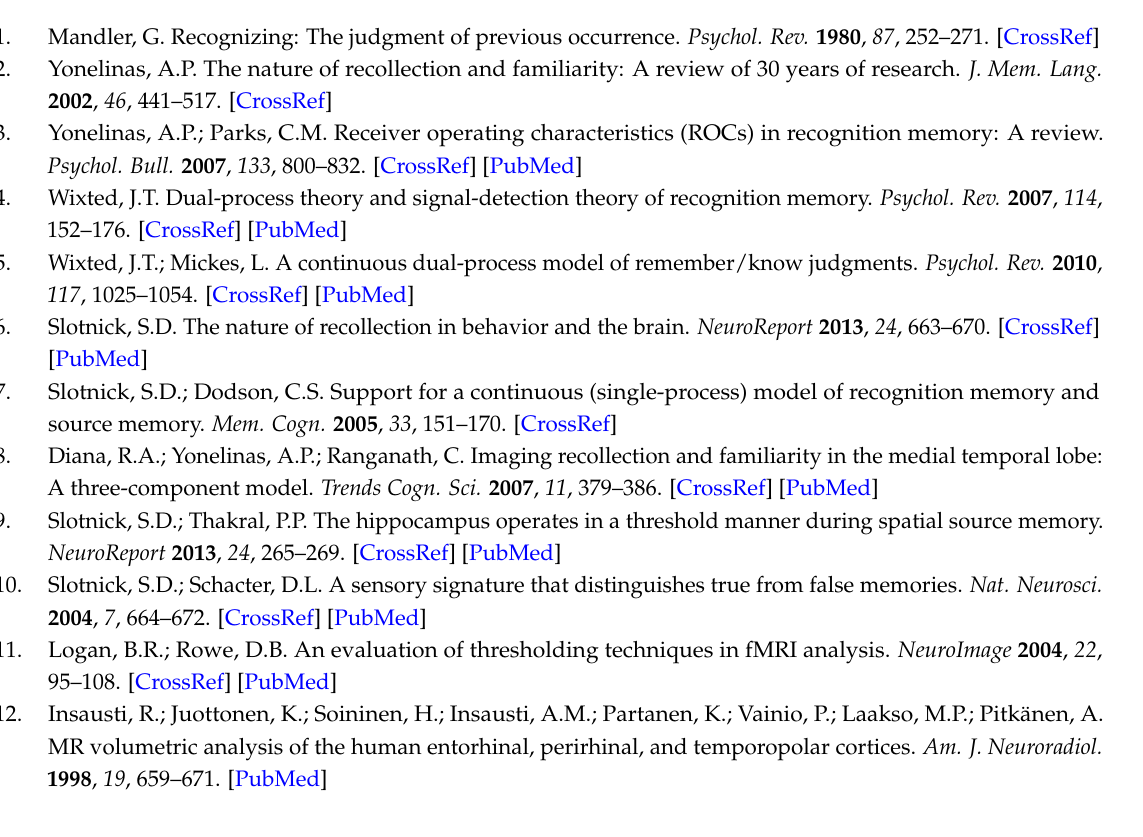
Figure A3. Hippocampal ROC from Slotnick and Thakral (2013) with the best-fit continuous unequal variance model and two-high threshold model ROCs (key at the bottom right).